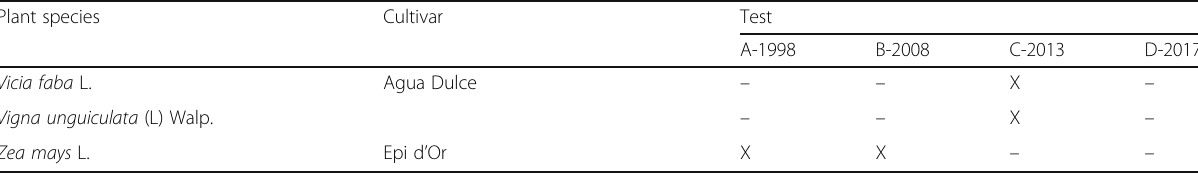
Table 5 Plant species and cultivars used in the four different tests of this study a (Continued) Plant species